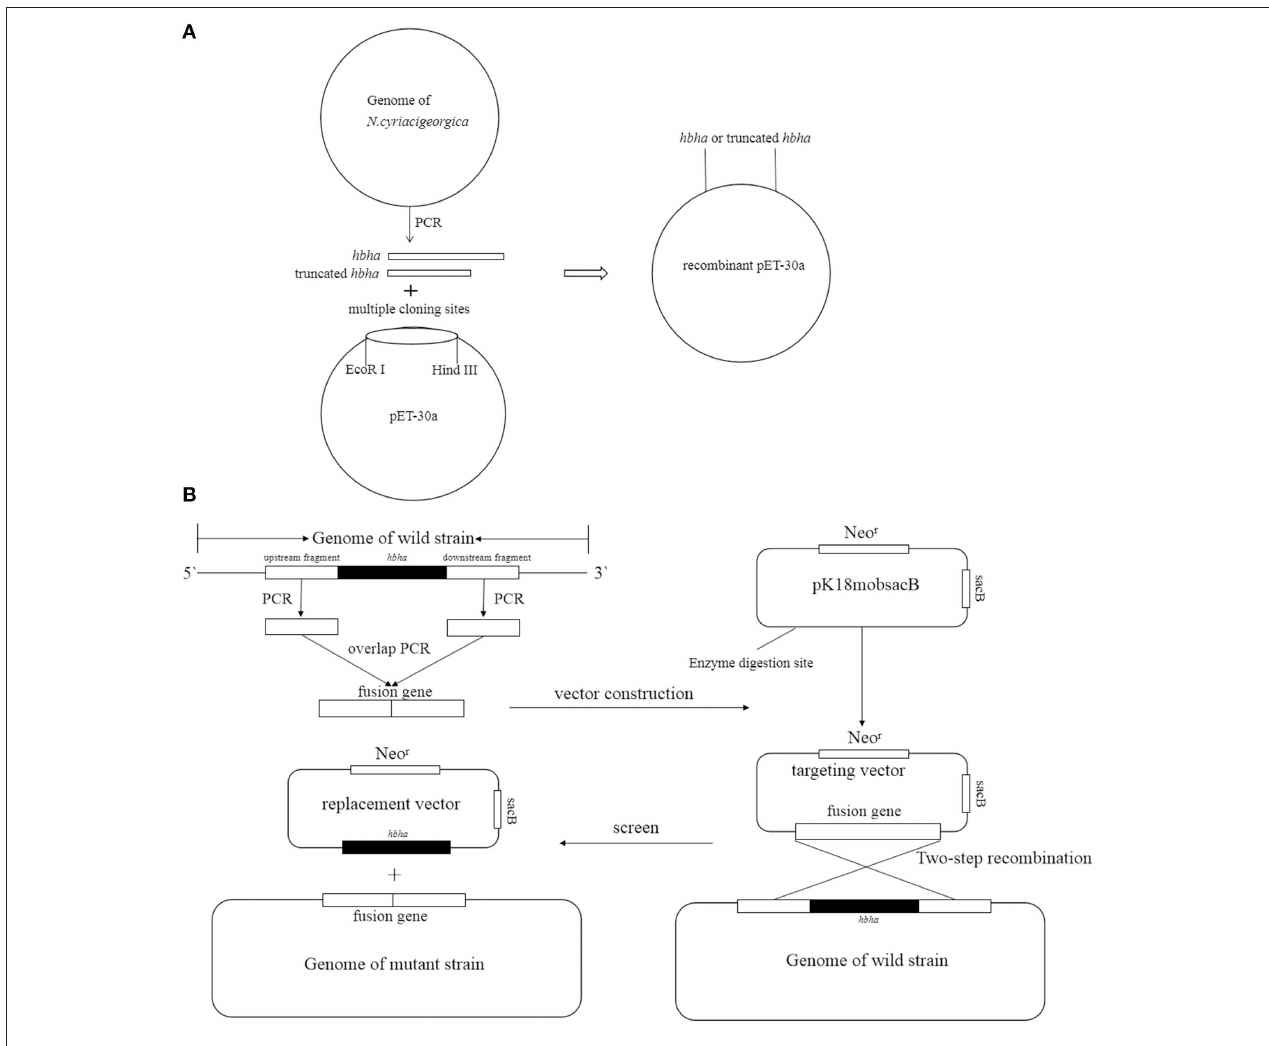
FIGURE 1 | Strategy of construction recombinant pET30a (A) and deletion hbha gene in N. cyriacigeorgica (B) .